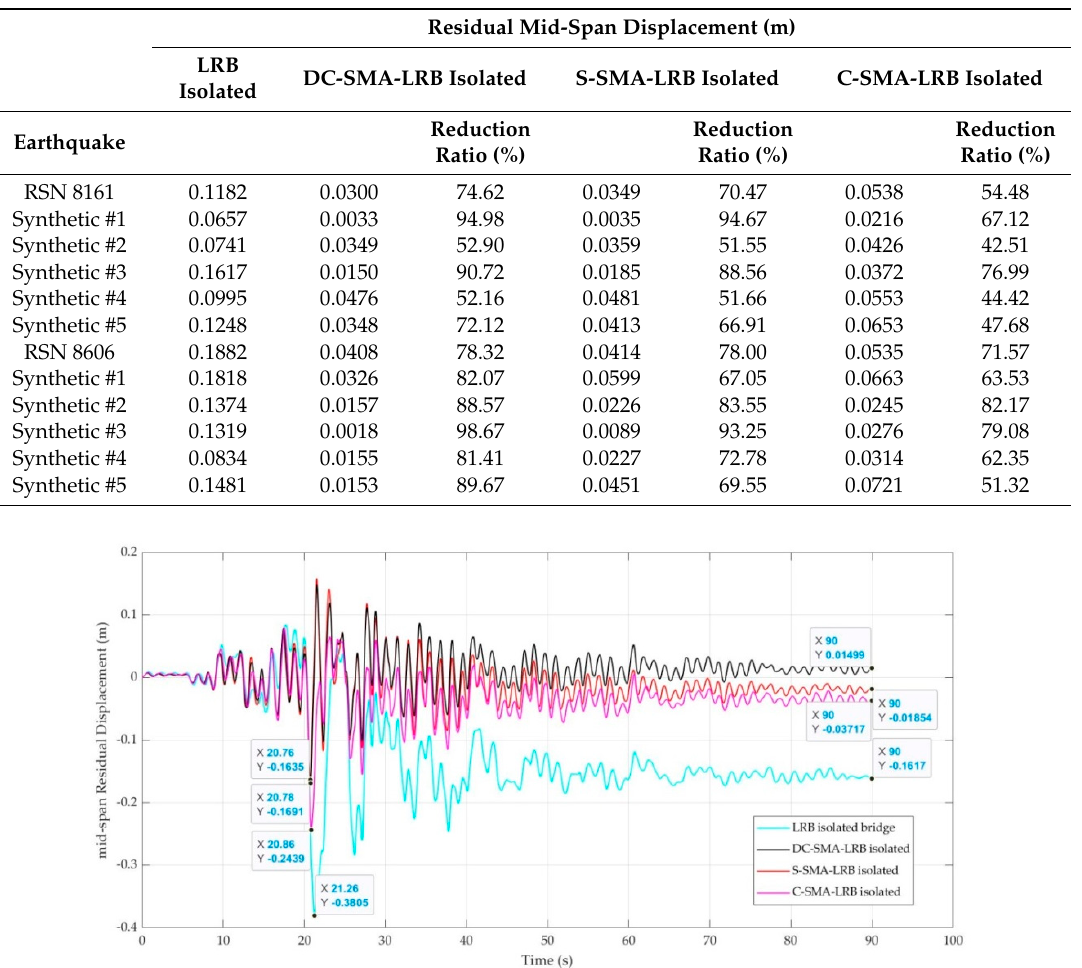
Figure 17. Time history curves of the mid-span displacement under synthetic#3 of the RSN8060 record. Figure 18. Graphical demonstration of the mid-span residual displacement for the LRB-isolated and three SMA-LRB isolated bridges. 6.5. Comparing the Three SMA-LRBs SMA wires can be wrapped around the LRB isolators in double-cross, straight, and cross arrangements to improve the seismic performance of the isolated structure. On the one hand, it is 00.050.10.150.2 R e s i du a l m i d - s p a n D i s p l a c e m e n t ( m )